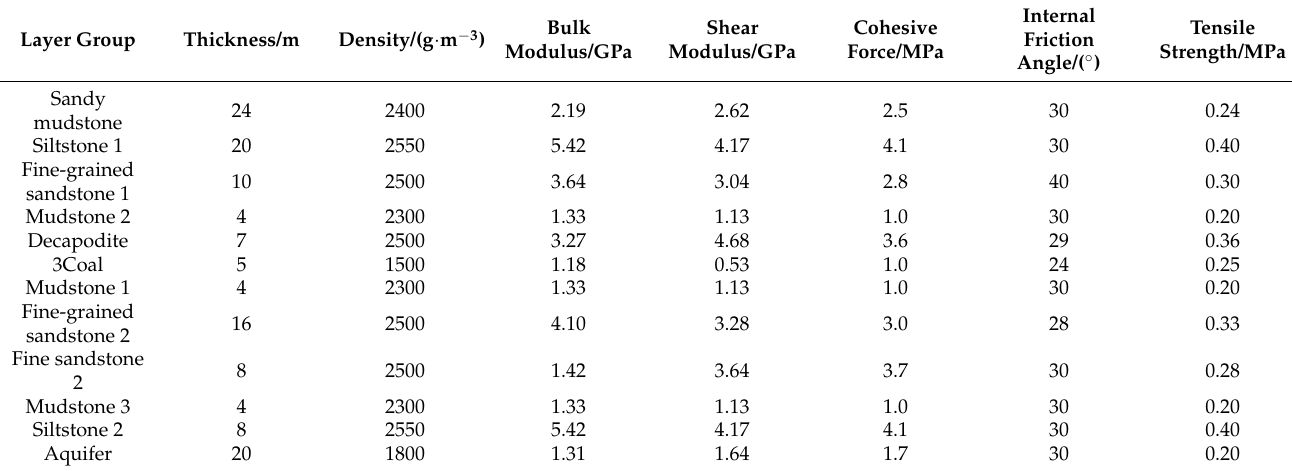
Table 1. Physics mechanics parameter of model terrane.